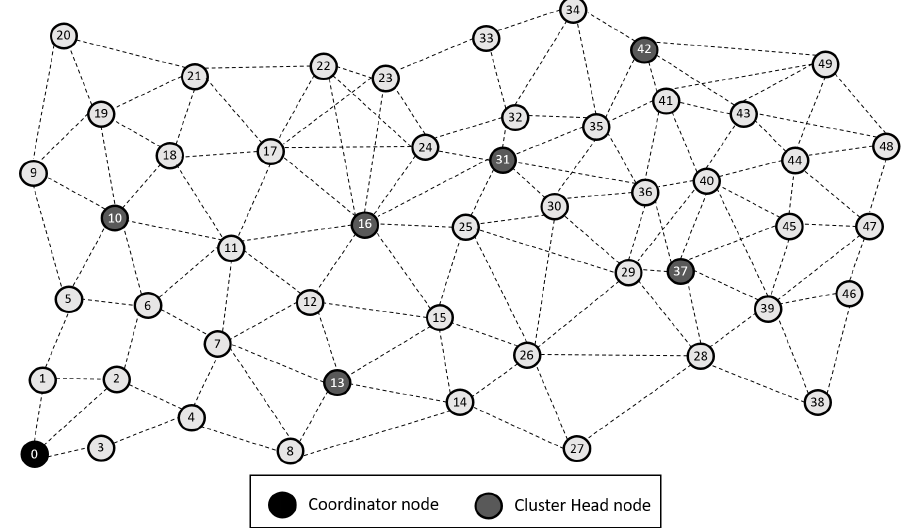
Figure 1. Network grid